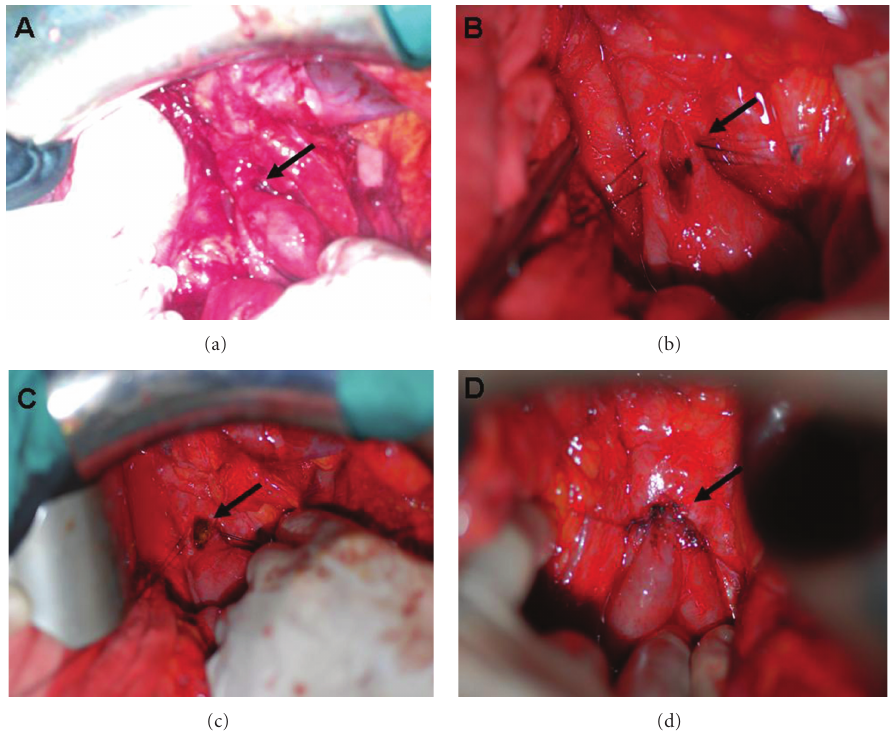
Figure 2: (a) The arrow shows the stricture of the hepaticojejunostomy anastomosis. (b) The arrow shows the vertical incision at the anastomotic line. (c) The arrow shows the gallstone, which was extracted trough the incision. (d) The arrow shows transverse closure of the vertical